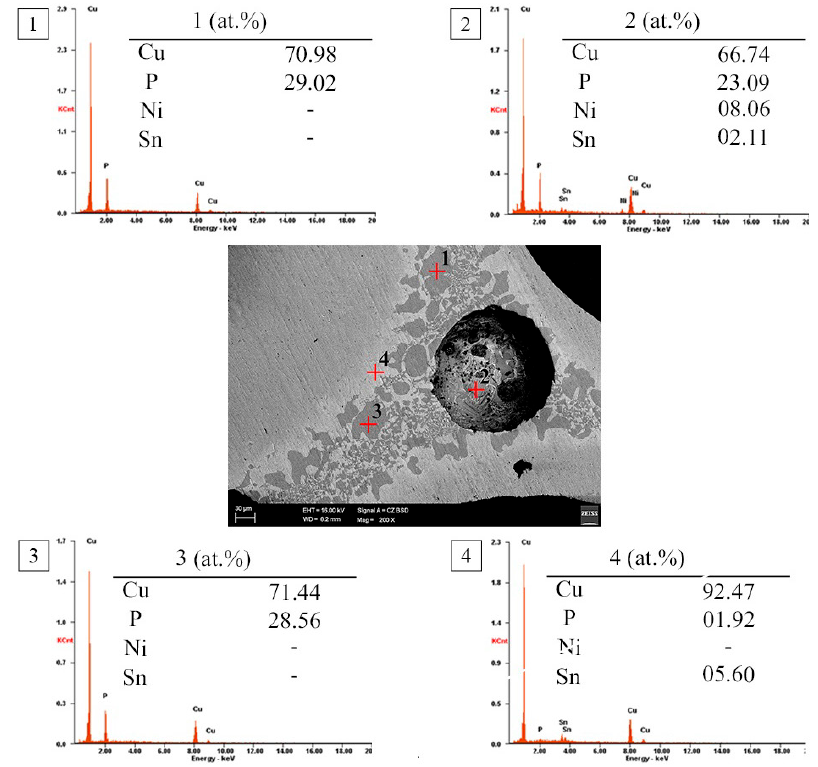
Figure 6. SEM micrographs with marked points (1–4), and EDX peak pattern (with respect to points 1–4) of porous Cu brazed at 680 ° C for 15 min.